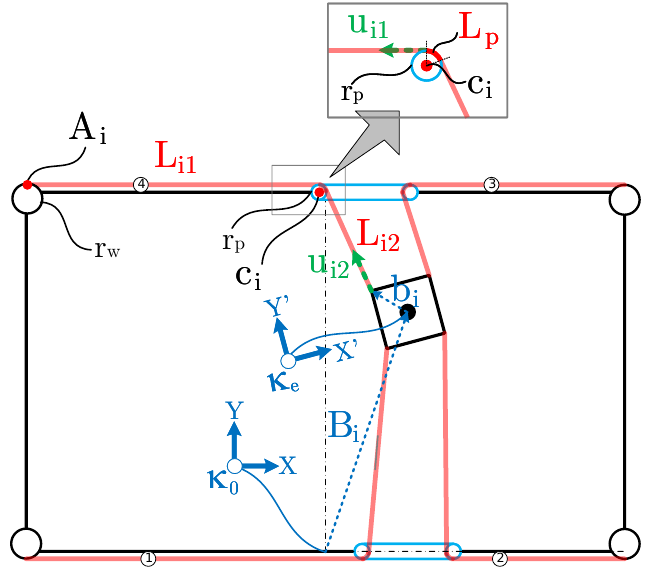
Figure 5. Nomenclature: arrays and points of